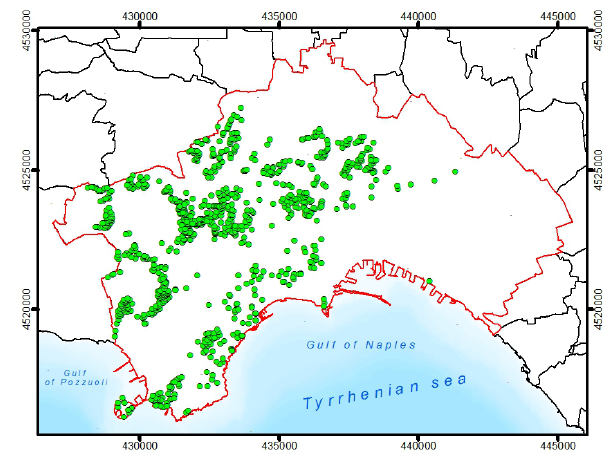
Fig. 4. Landslide-inventory map of the city of